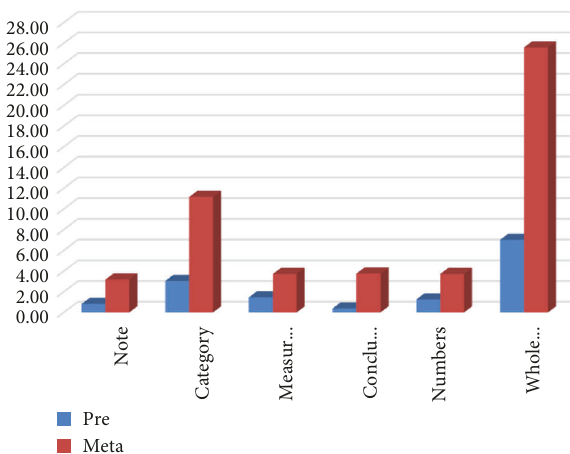
Figure 1: Arithmetic averages of children’s scores in the two applications, pre and post, to test the basic scientific processes. Table 9: The size of the impact of using the proposed unit based on the STEM approach in developing some basic science processes. Concept